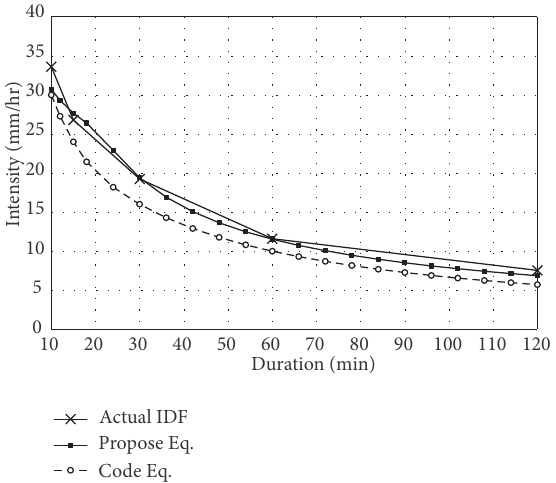
Figure 5: Comparison of rainfall intensity curve 𝐼 (mm/hr) for Cairo.